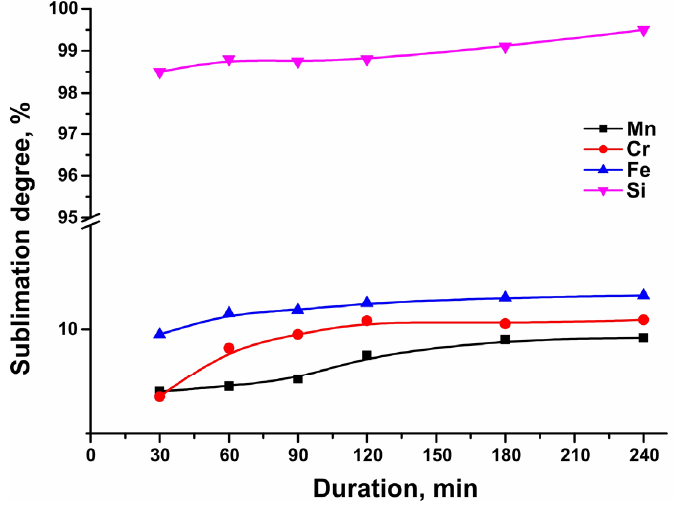
Figure 8. Influence of process duration on sublimation of impurities from fluorinated dust of electric melting of ilmenite concentrate. Table 5. Effect of the duration of the experiment on the content of impurity components in the cinder. Content * in the Cinder, Duration, min